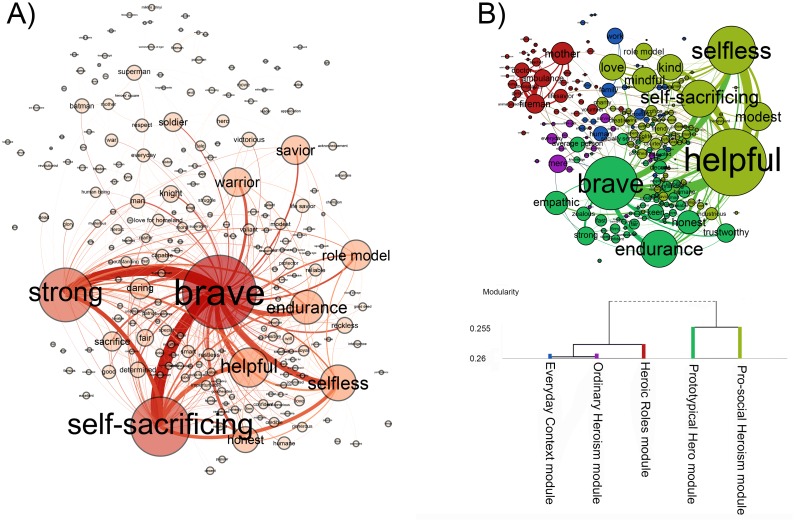
The social representations of Hero (A) and Everyday Hero (B).The association networks are visualized with the ForceAtlas 2 layout [50]. The size of a node denotes the node strength and the thickness of an edge refers to the edge weight. The networks were thresholded (edges below the value of 1 were deleted) for a better visualization. In case of Everyday Hero, nodes with the same color belong to the same module. The hierarchy and descriptive labels of the modules are presented on the dendrogram.